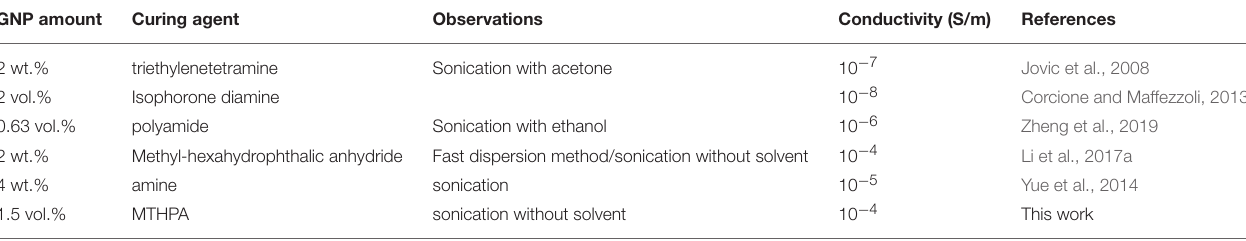
TABLE 1 | Comparative results of electrical conductivity of epoxy/GNP composites. GNP amount